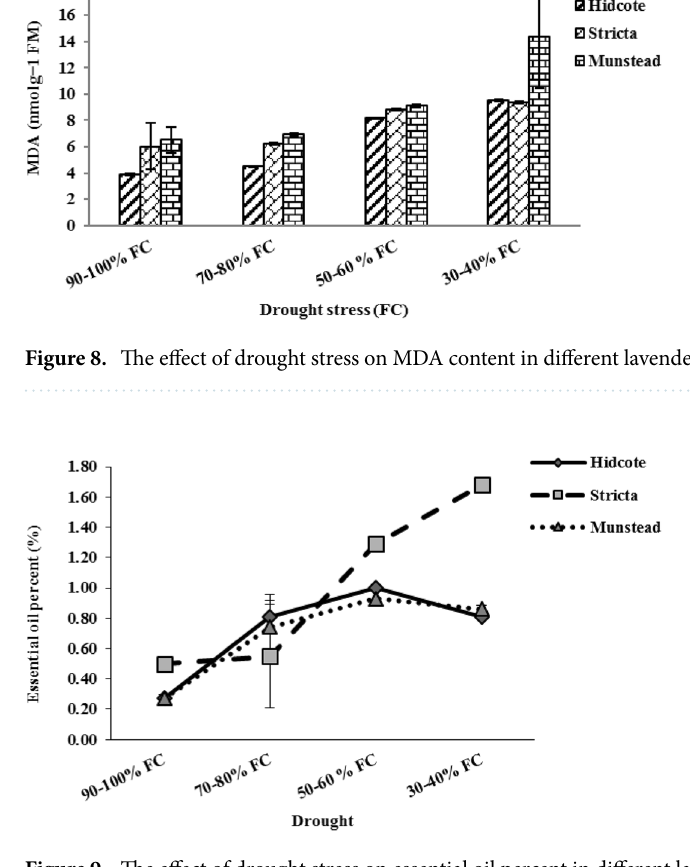
Figure 9. The effect of drought stress on essential oil percent in different lavender